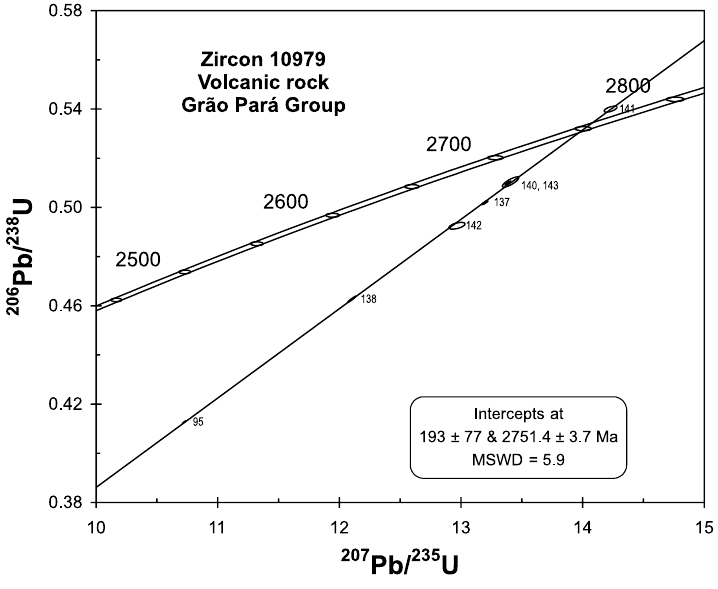
*Radiogenic isotopes. / **Small fraction of zircon crystals. Excepting point 95, which correspond to a large multi-grain fraction, the average weights were estimated by volume on the base of microphotography of the grain. / Pb corrected for common lead using Stacey and Kramers (1975) model for t = 0 Ma.